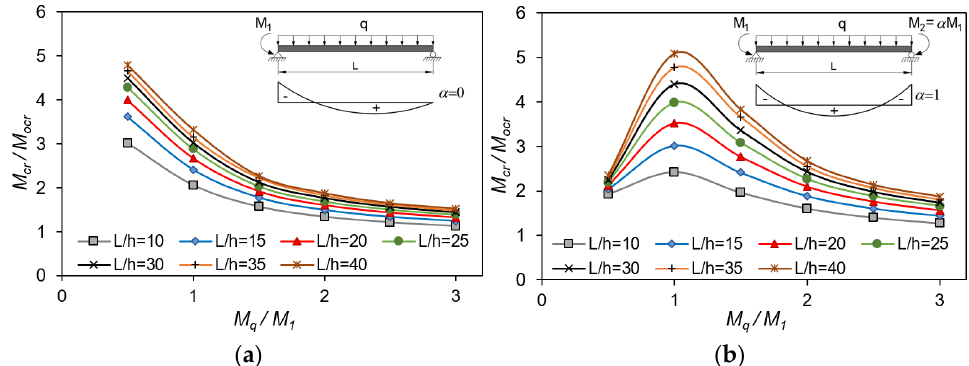
Figure 7. Finite element analysis results for LC 1 . (a) α = 0. (b) α = 1.